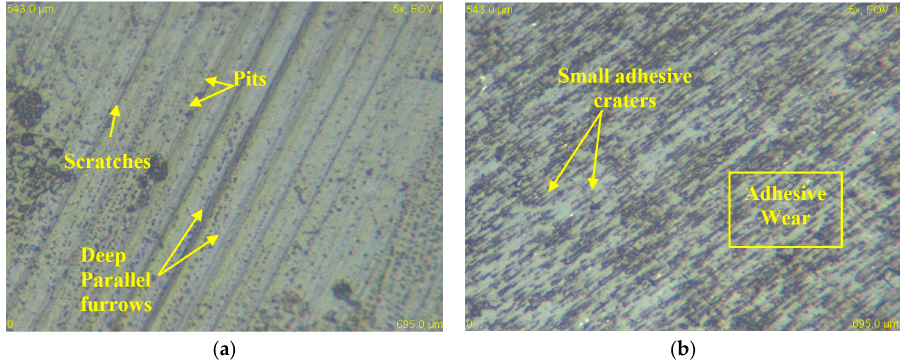
Figure 14. Wear analysis of worn surfaces Si3N4: ( a ) 0.2 m/s, ( b ) 1.2 m/s.